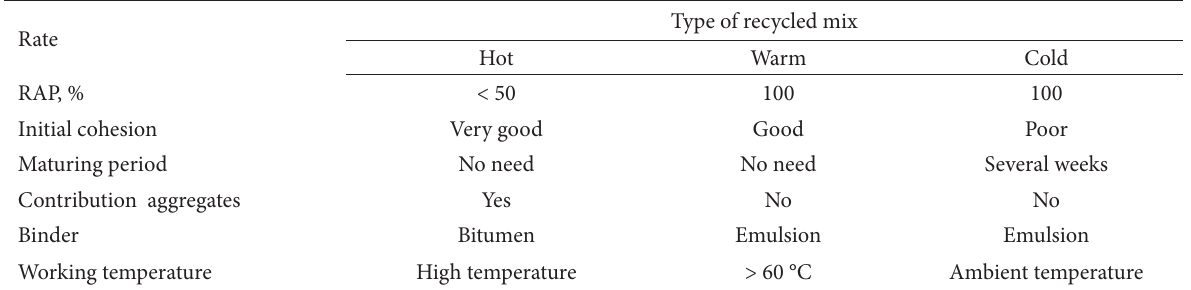
Table 2. Comparison between different types of recycled mixes (Soto Sánchez